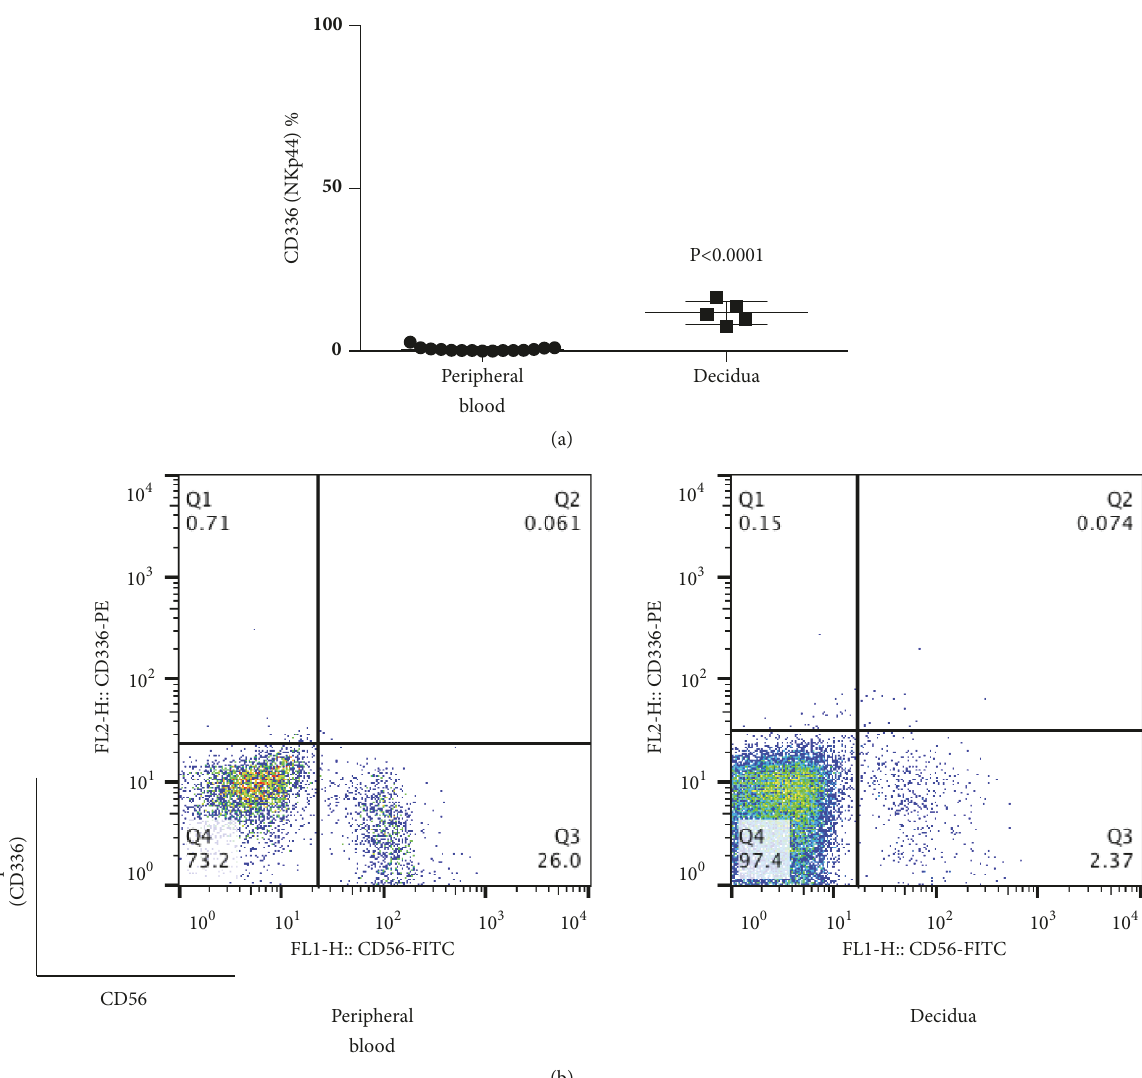
Figure 6: (a) Percentage of CD336 (NKp44)+ cells among CD56+CD3- cells at term pregnancy in peripheral blood and decidua. The percentage of CD336 (NKp44)+ cells among CD56+CD3- lymphocytes was higher than in peripheral blood. (b) Representative dot plot analysis of CD336 (NKp44)+ cells among CD56+CD3- lymphocytes taken from term pregnancy by flow cytometry. The gate was set around the CD3- lymphocytes to analyze the CD336+CD56+ NK